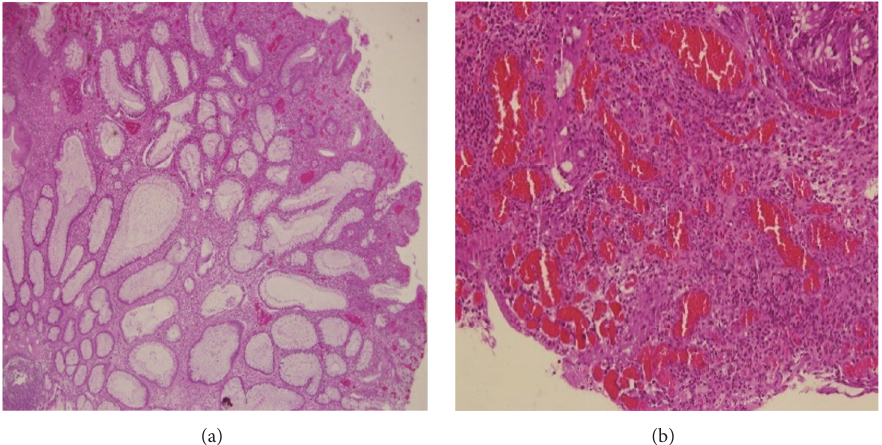
Figure 2: Edematous lamina propria, cystically dilated glands (a) with inflammatory cells (b) in resected tissue obtained from colonoscopic polypectomy (H&E stain, × 40).